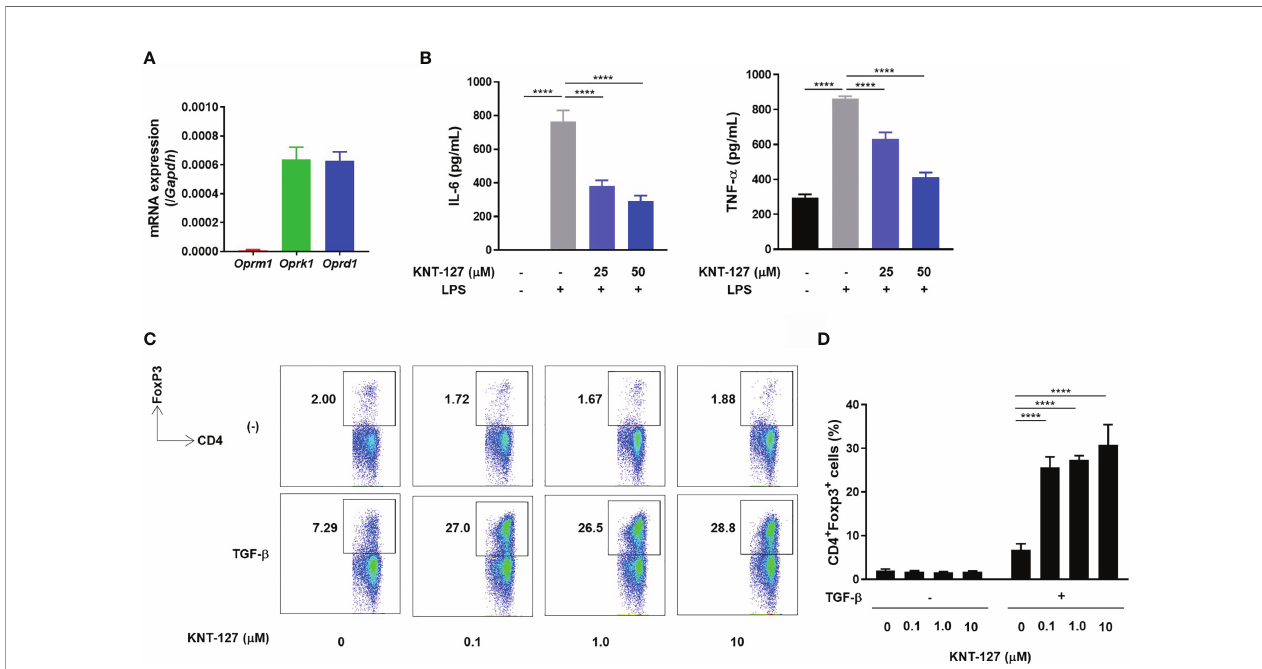
FIGURE 6 | Direct effects of KNT-127 on immune cells in vitro. (A) mRNA levels of opioid receptors in BMDMs. The mRNA expression of each gene of interest was normalized to that of GAPDH by calculation of the cycle threshold values. (B) TNF- a and IL-6 protein concentrations in the culture supernatant of BMDMs. BMDMs (5.0×10 5 cells/500 m L) were incubated in the presence of KNT-127 for 30 minutes, followed by stimulation with 100 ng/mL LPS. The culture supernatant was harvested 6 hours after LPS stimulation, and the TNF- a and IL-6 concentrations were measured by ELISA. (C, D) Naïve CD4 + T cells puri fi ed from the spleen were stimulated in a plate coated with anti-CD3 ϵ and anti-CD28 Abs in the presence of 3 ng/mL TGF- b . The frequency of Tregs (CD3 ϵ + CD4 + Foxp3 + cells) was determined by fl ow cytometry. The data represent the mean ± SD of triplicate samples. Similar results were obtained in three independent experiments. **** P < 0.0001; n.s., not signi fi cant (one-way ANOVA followed by Dunnett ’ s multiple comparisons test, vs